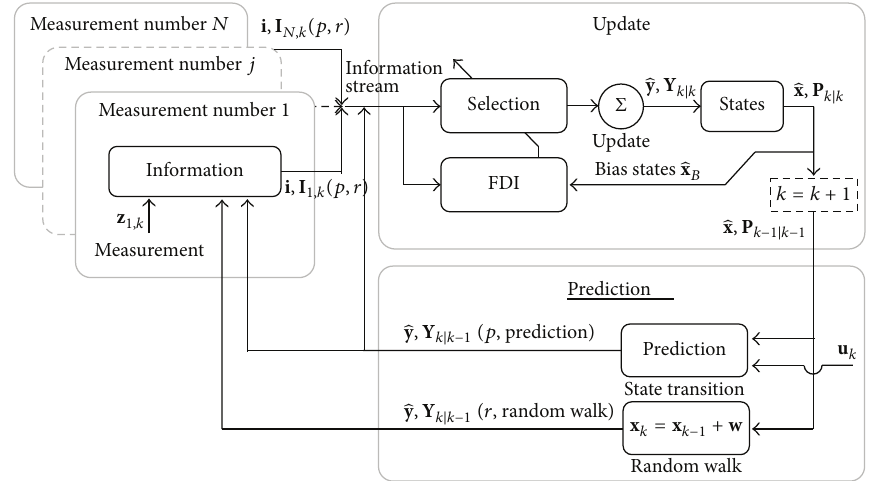
Figure 2: Overall sensor fusion algorithm architecture.